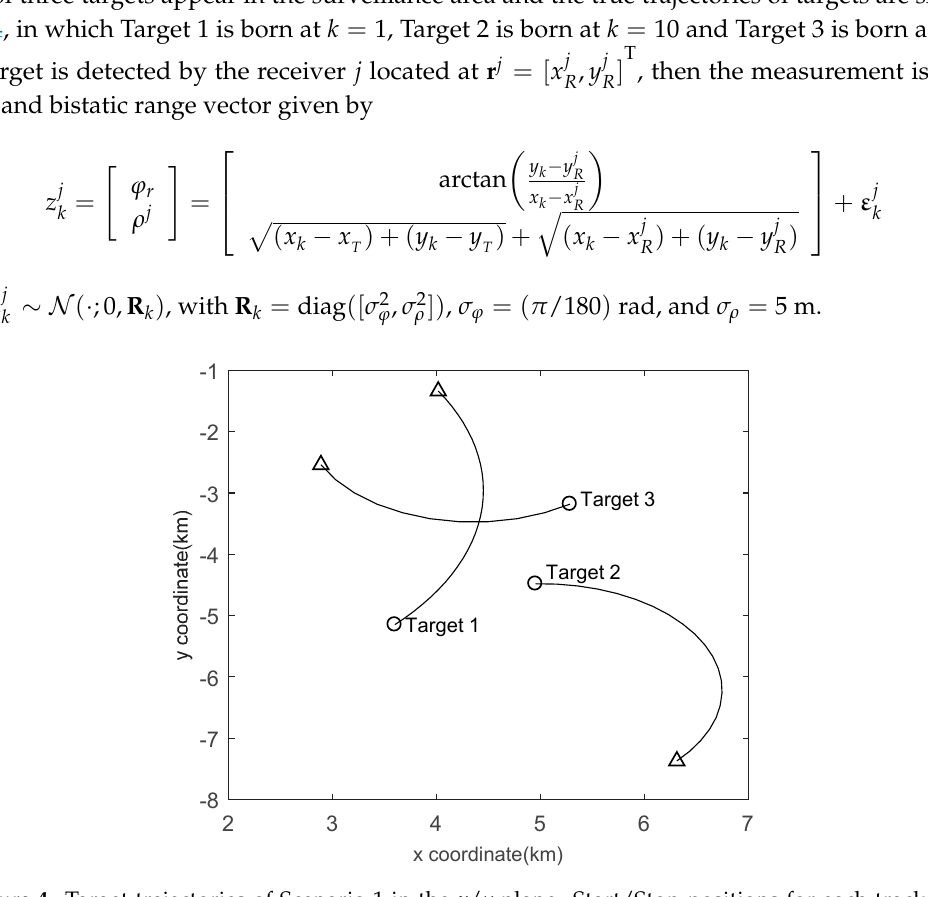
Figure 4. Target trajectories of Scenario 1 in the x / y plane. Start/Stop positions for each track are shown with ○ / △ .